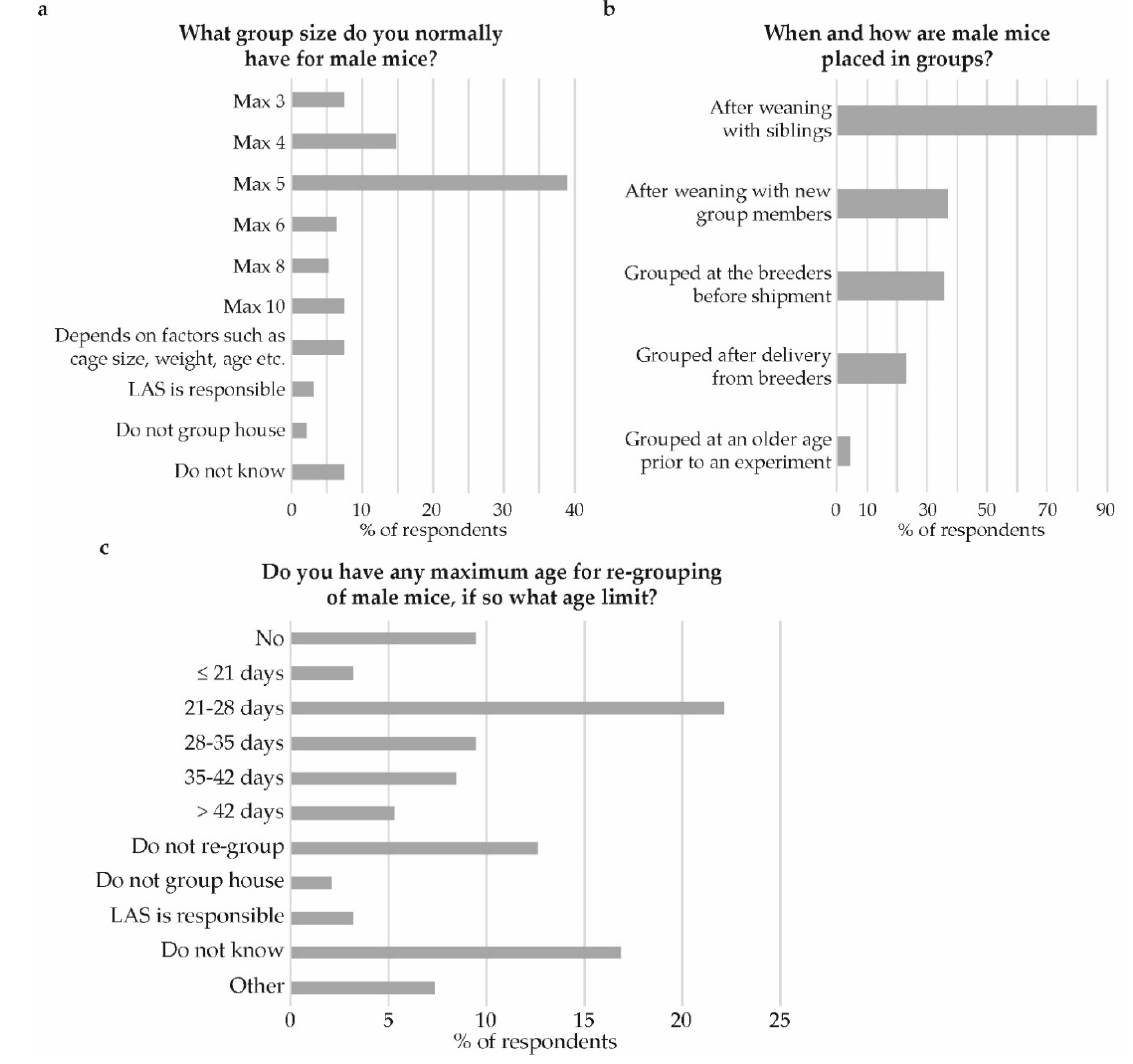
Figure 6. Establishment of male groups. ( a ) What group size do you normally have for male mice? ( b ) When and how are male mice placed in groups? And, ( c ) Do you have any maximum age for re-grouping of male mice, if so what age limit? Note: in panel ( b ) the wording used in the survey was “grouped at the breeders before delivery” .